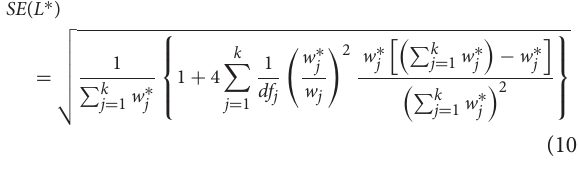
( SL ), and the categorical variables were vegetation ( V2 ), soil ( SO ), P inputs in adjacent fields ( PF2 ), on-site infiltration capacity ( IC ), and P removal pathway ( PW ). The